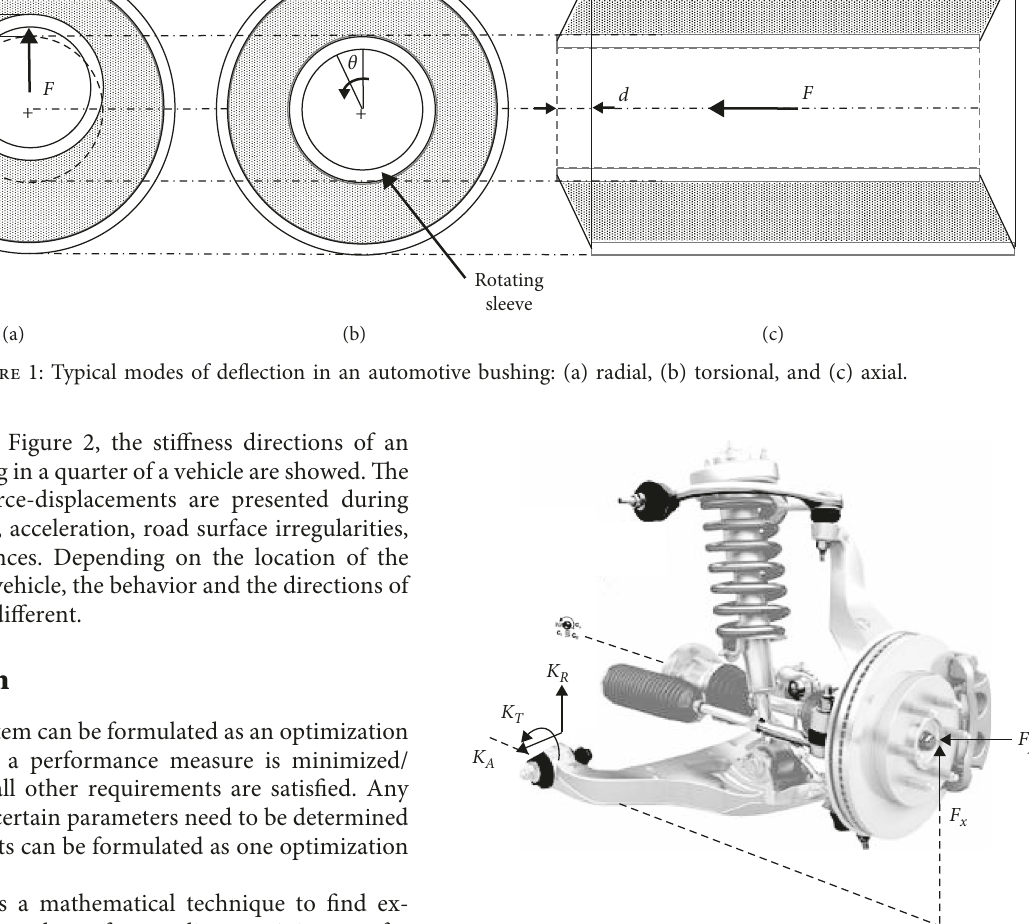
Figure 2: Lower control arm bushing with radial, torsional, and axial stiffness